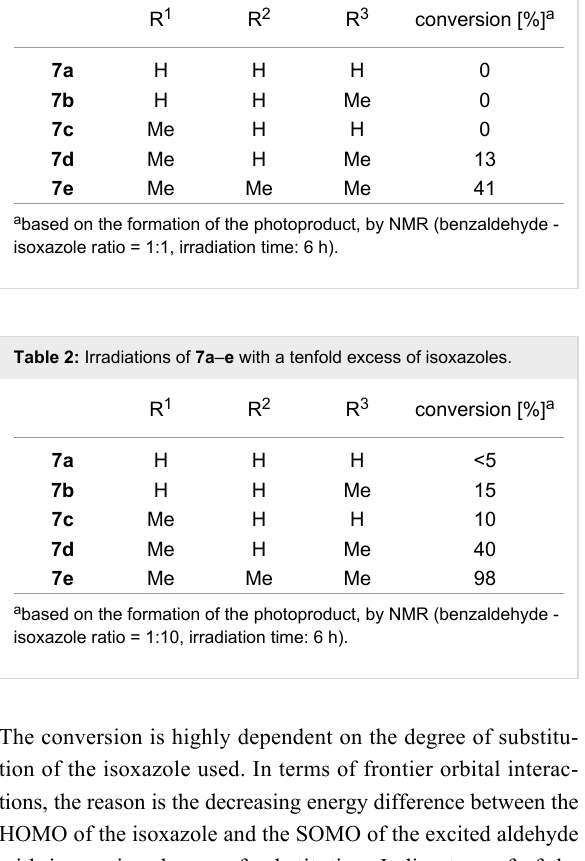
Table 1: Irradiation of isoxazoles 7a – e with benzaldehyde. R 1